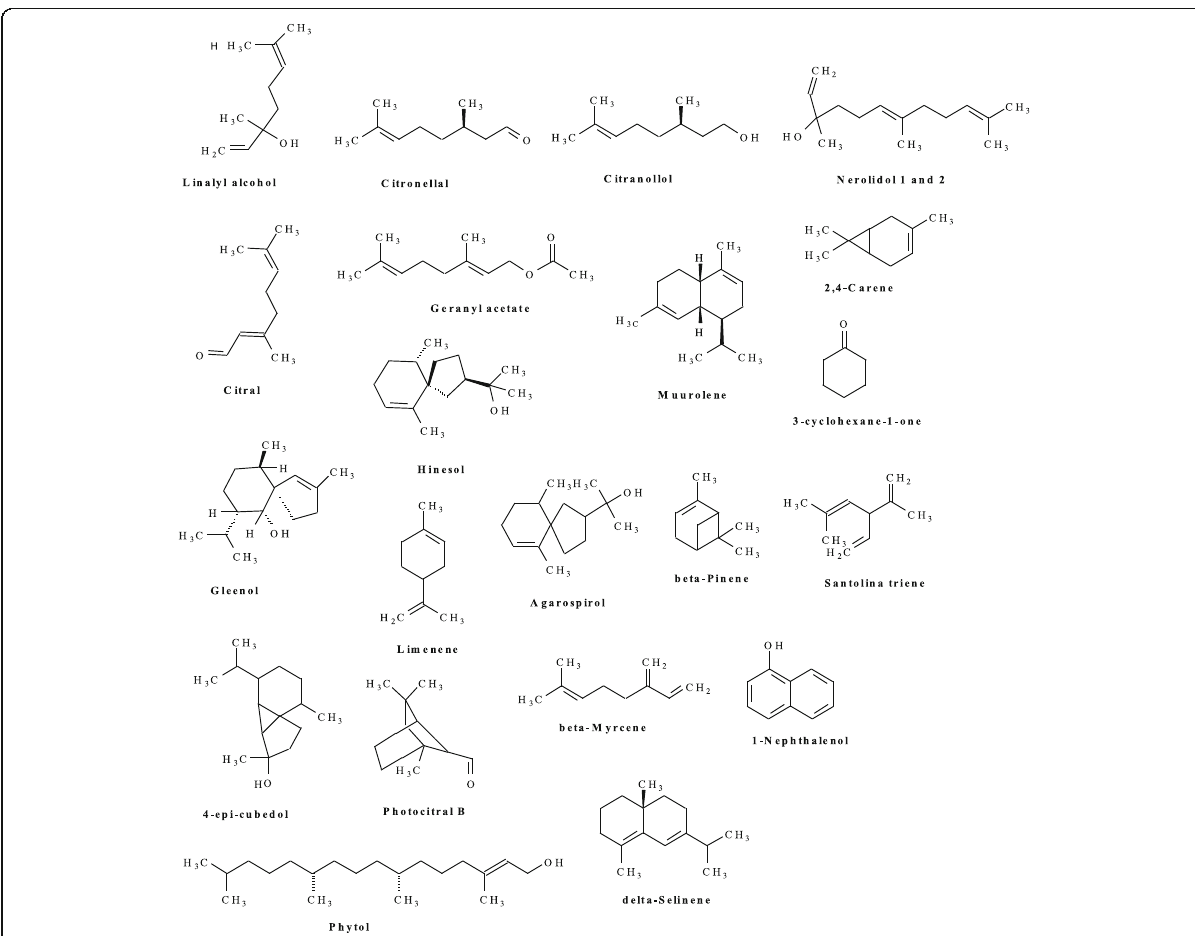
Fig. 2 Some of the identified phyto-compounds that possesses antibacterial